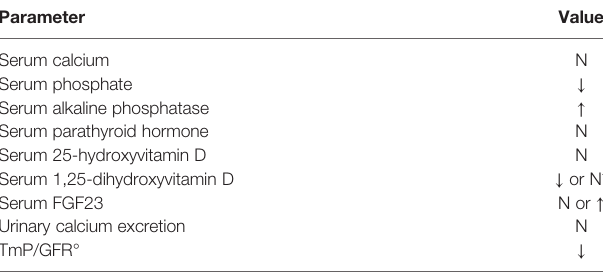
TABLE 2 | Main biochemical fi ndings in patients with XLH. Parameter